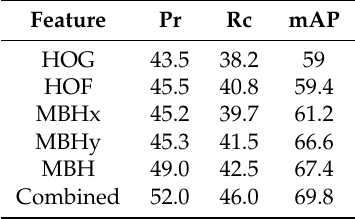
Table 3. Recognition accuracies of different features